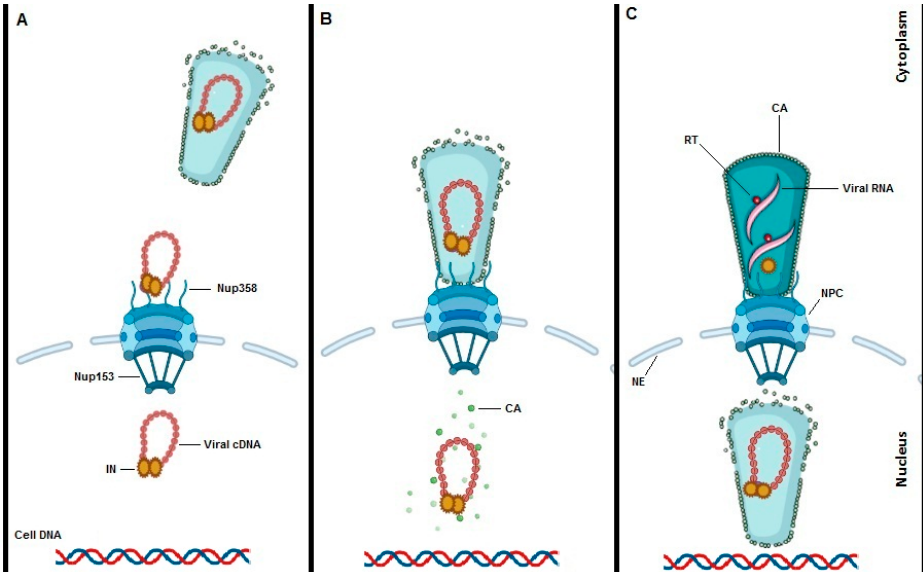
Figure 2. Models of HIV-1 uncoating. To date three potential models for HIV-1 uncoating are proposed. “Immediate uncoating” points to the early disassembly of the HIV-1 core inside the cytoplasm during the first hour of infection and prior to NPC docking ( A ). Uncoating at the NE is supported by imaging experiments showing that uncoating occurs when the core is stalled at the NPC. ( B ). Recent studies are claiming a “nuclear uncoating” mechanism and represent the third model of HIV-1 uncoating ( C ). In the third model, intact HIV-1 cones enter into the cell nucleus, reverse transcription is completed, and uncoating and integration are all completed inside the nucleus and close to the integration site.